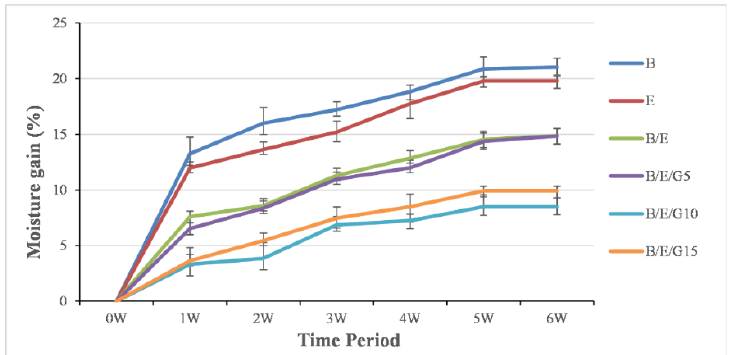
Figure 9. Moisture absorption of basalt and E-glass hybrid composites.